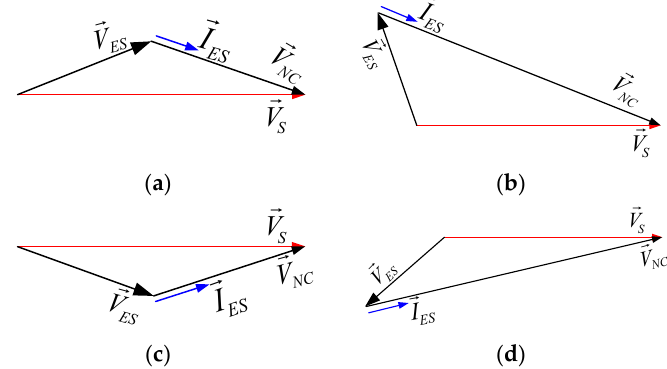
Figure 5. Vector diagrams under other types of compensation modes with pure resistive NCL. ( a ) Inductive plus positive real; ( b ) Inductive plus negative real; ( c ) Capacitive plus positive real; ( d ) Capacitive plus negative real.